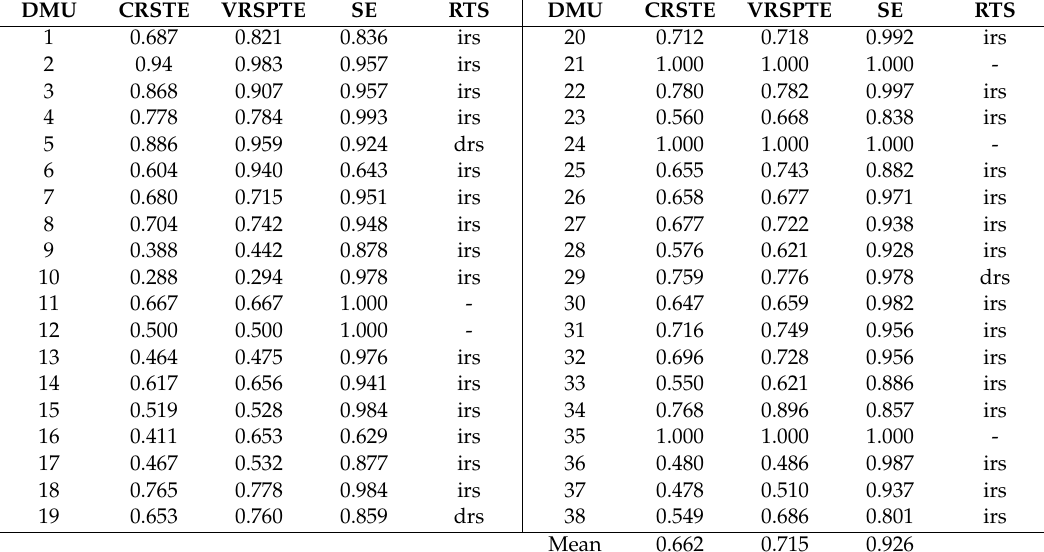
Table 3. E ffi ciency scores based on input-oriented